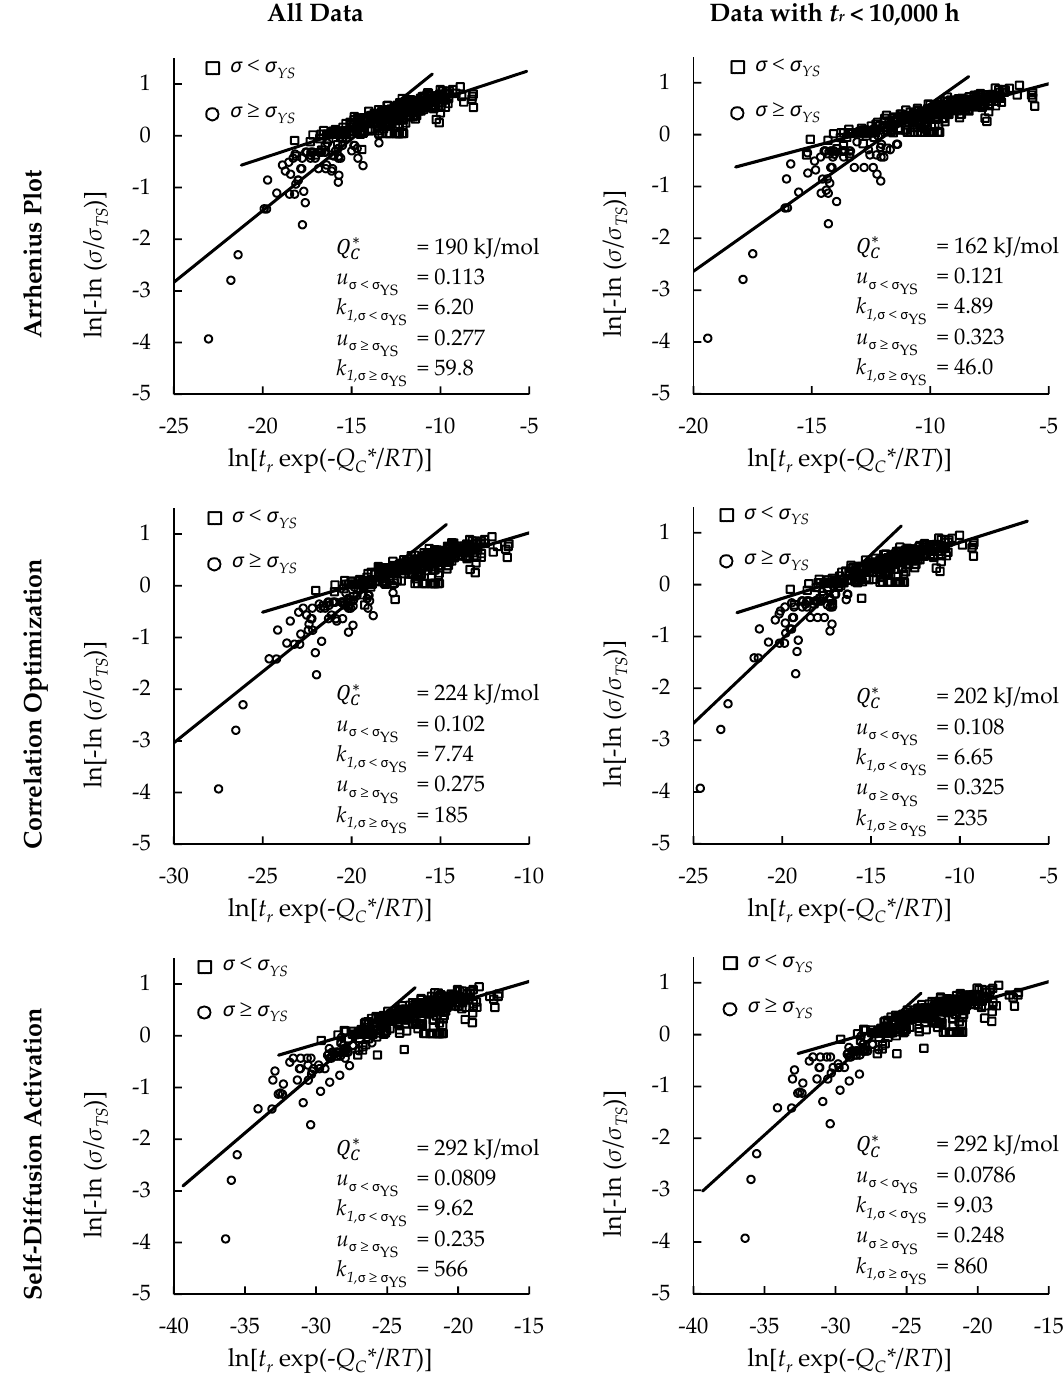
Figure A2. Wilshire plots of Inconel 617 creep rupture data split into above ‐ and below ‐ yield stress regions.